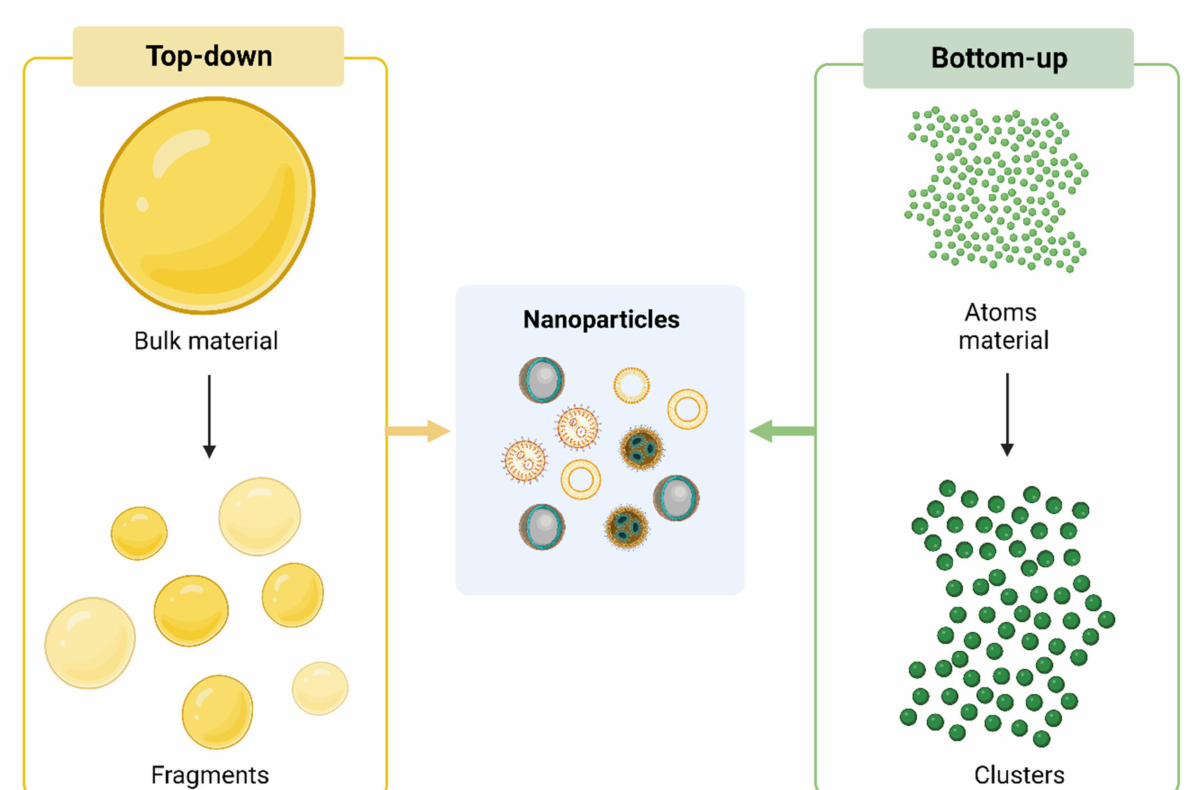
Figure 2. NPs synthesis . Current approaches employed for NPs synthesis: top down (on the left) and bottom-up (on the right). Created with